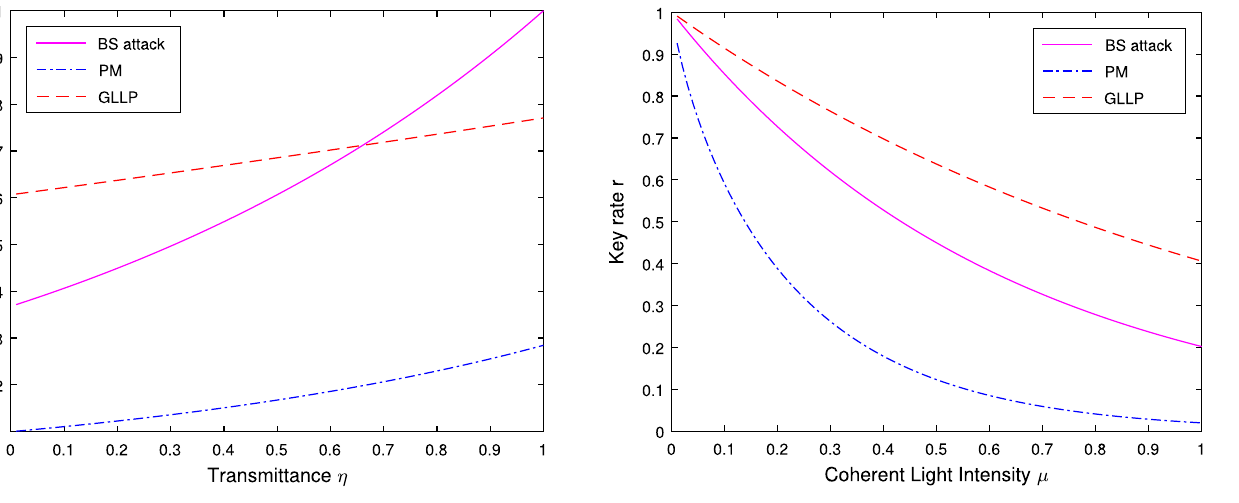
FIG. 8. Key-rate comparison with fixed light intensity μ ¼ 0 . 5 . Here, we can see that the GLLP tagging formula for the single- photon component cannot hold under the beam-splitting attack when the transmittance η < 0 . 6 .